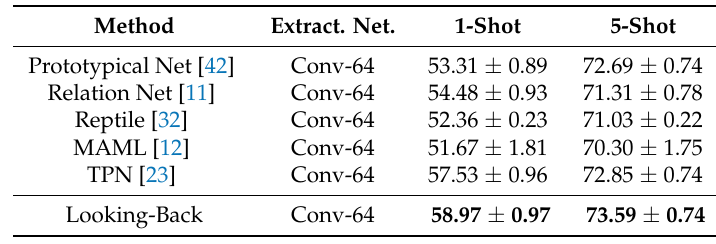
Table 2. Accuracy (in %) on tiered ImageNet with 95% confidence interval. Best results are shown in